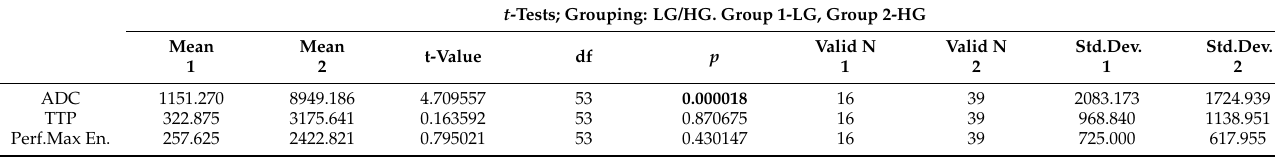
Table 3. Comparison of ADC, TTP and Perf. Max. En. between LG EOC and HG EOC